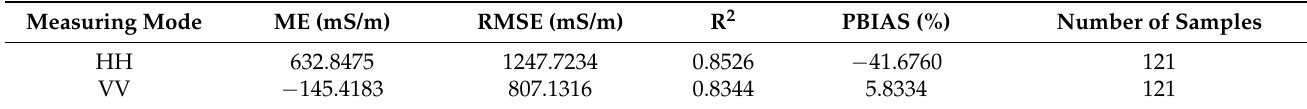
Table 11. Statistical data for accuracy assessment of the OK